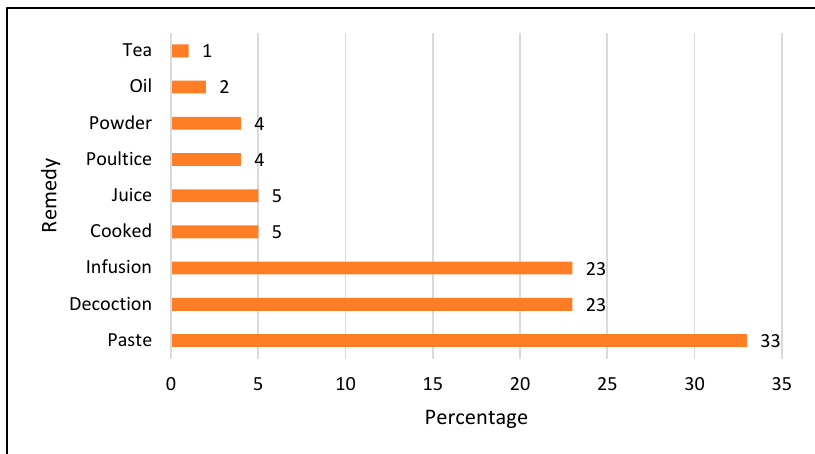
Figure 5. Percentage contribution of herbal remedies.